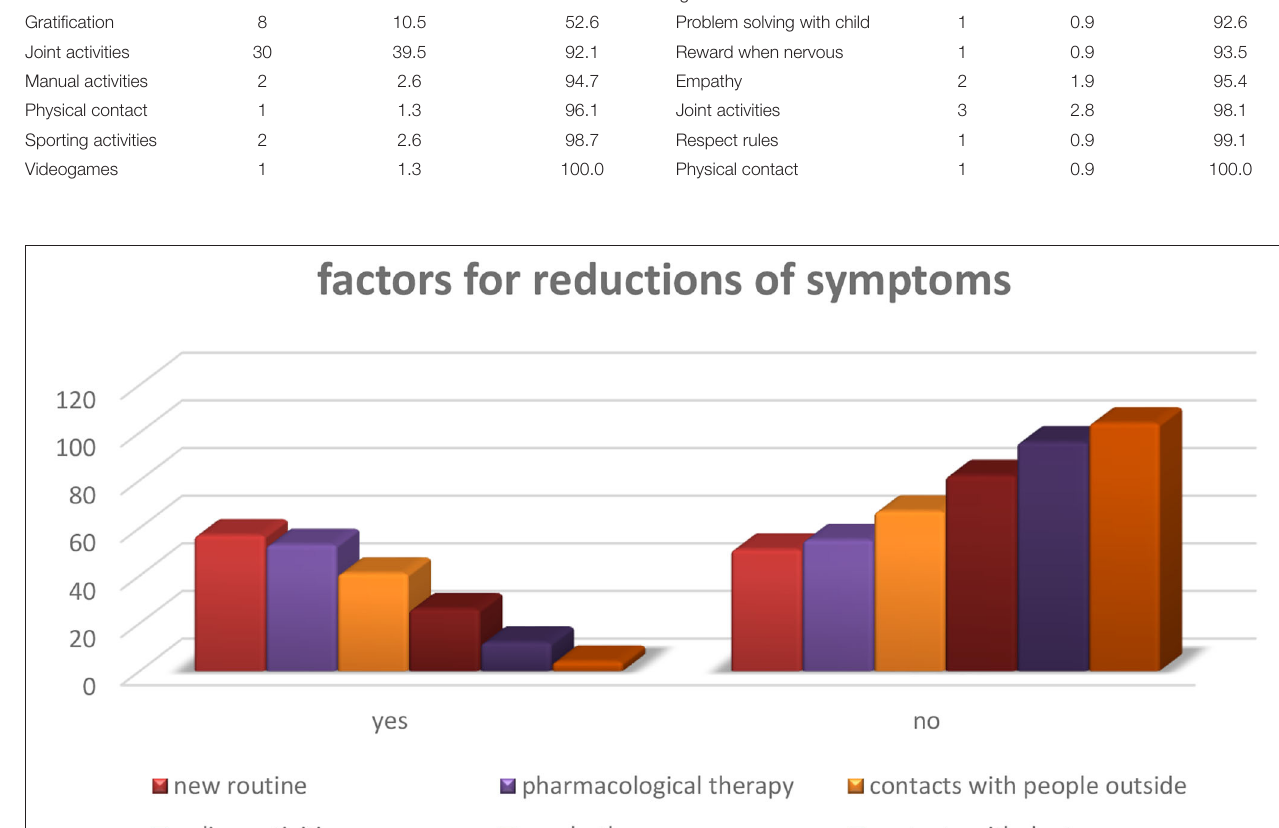
Frontiers in Neurology |